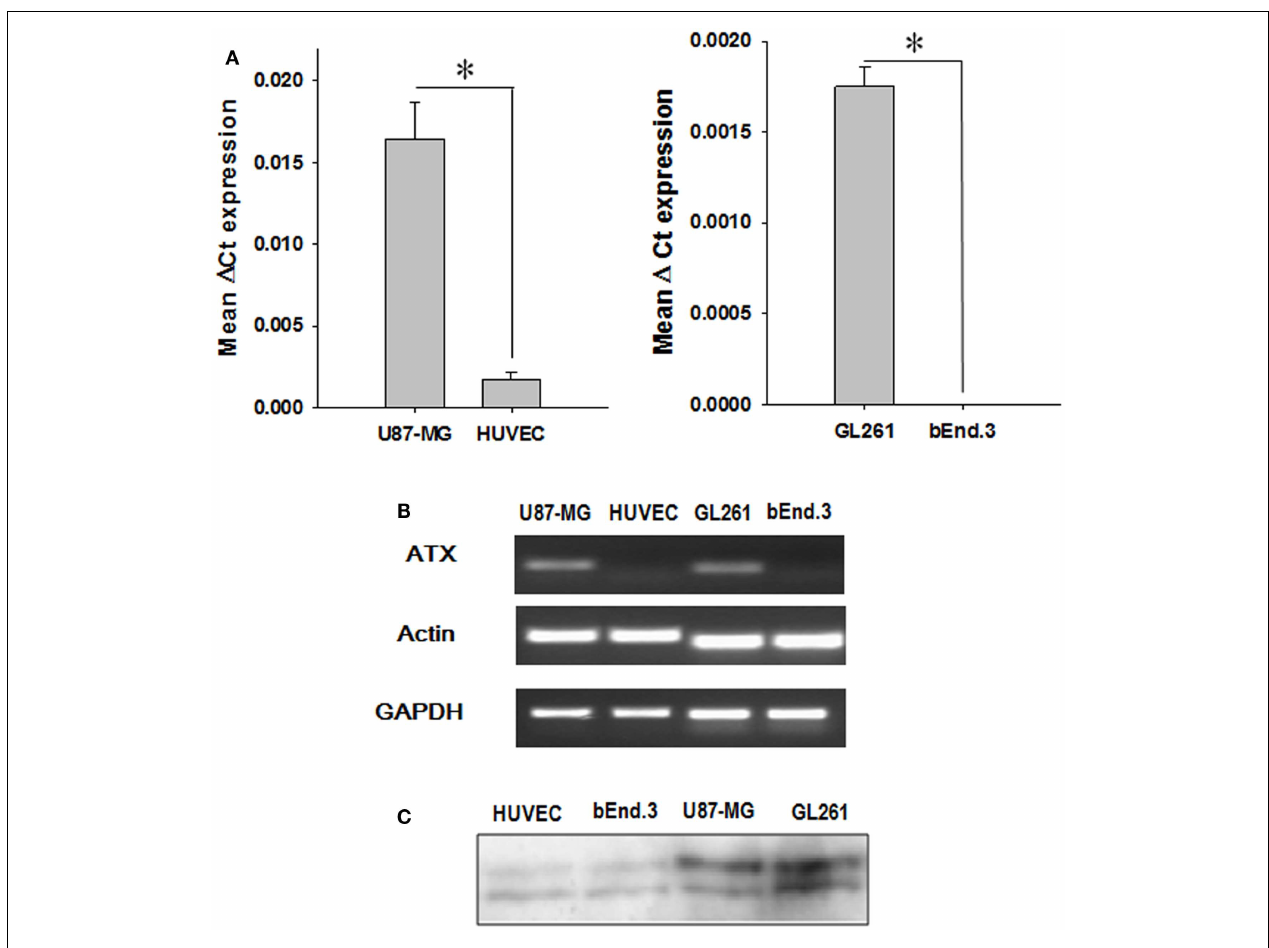
(B) A representative gel indicating the mRNA levels of ATX, actin, and GAPDH is shown. (C) The conditioned medium from endothelial cells (HUVEC and bEnd.3) and tumor cells (U87-MG and GL261) was concentrated and then were immunoblotted and probed with an anti ATX